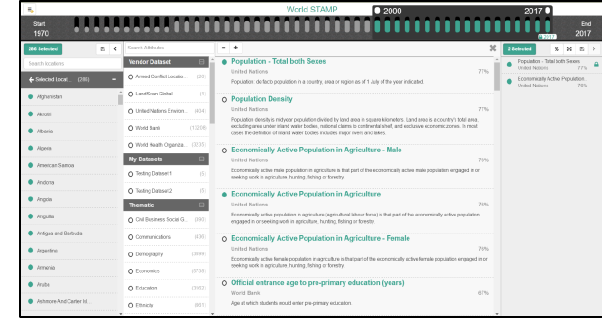
Figure 7. Expanded attribute search feature